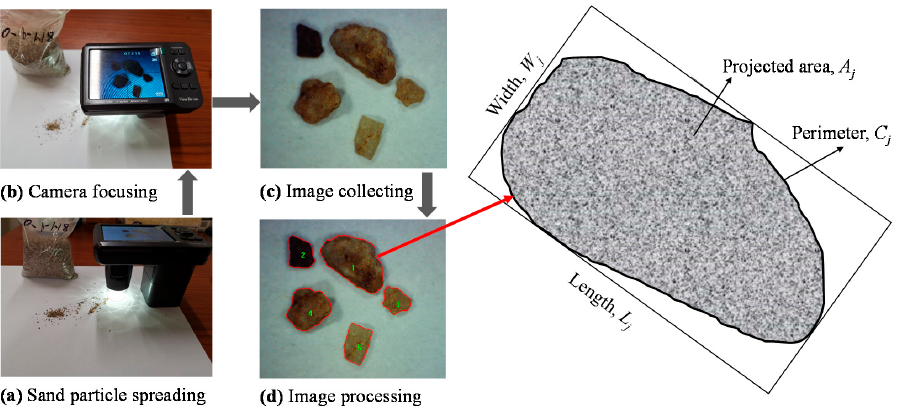
Figure 2. Process of obtaining the parameters of a sand particle.